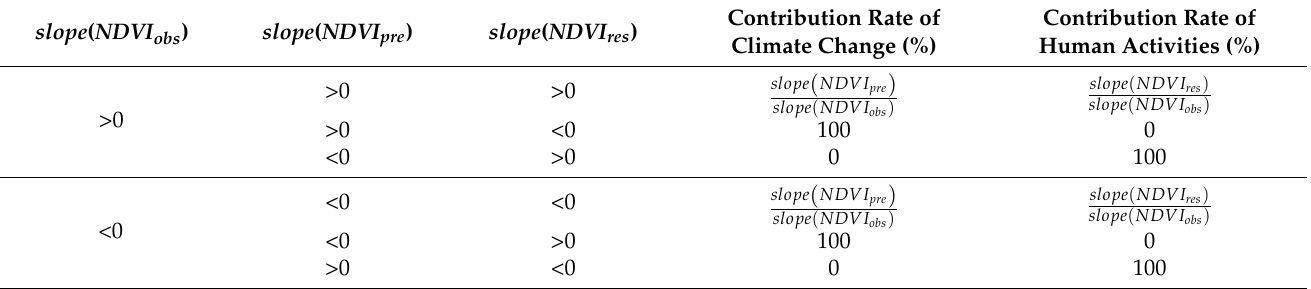
Table 1. Relative contributions of climate change and human activities to changes in vegetation